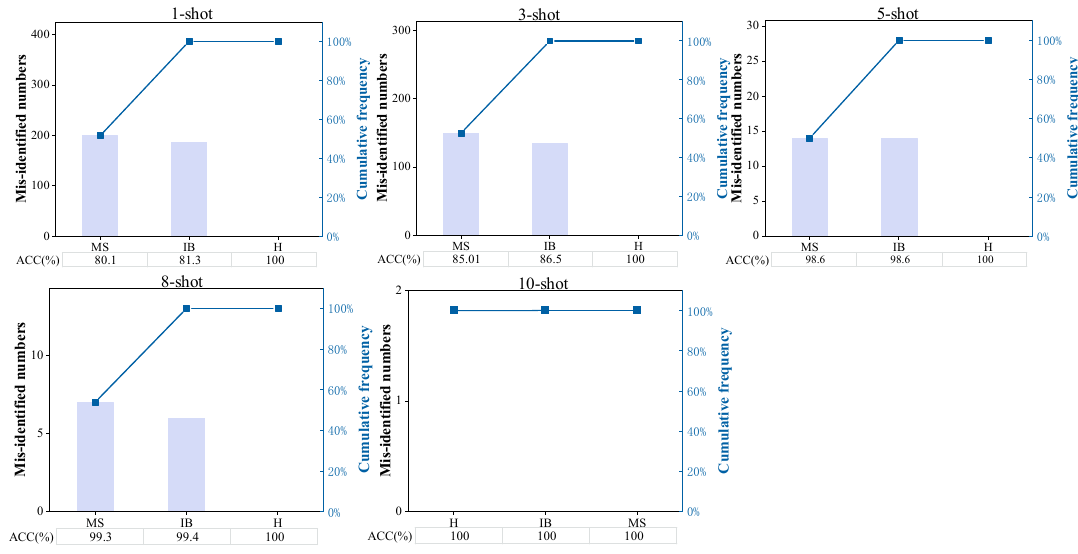
Figure 5. Diagnostic performance of WRRN method for five settings under task A1.